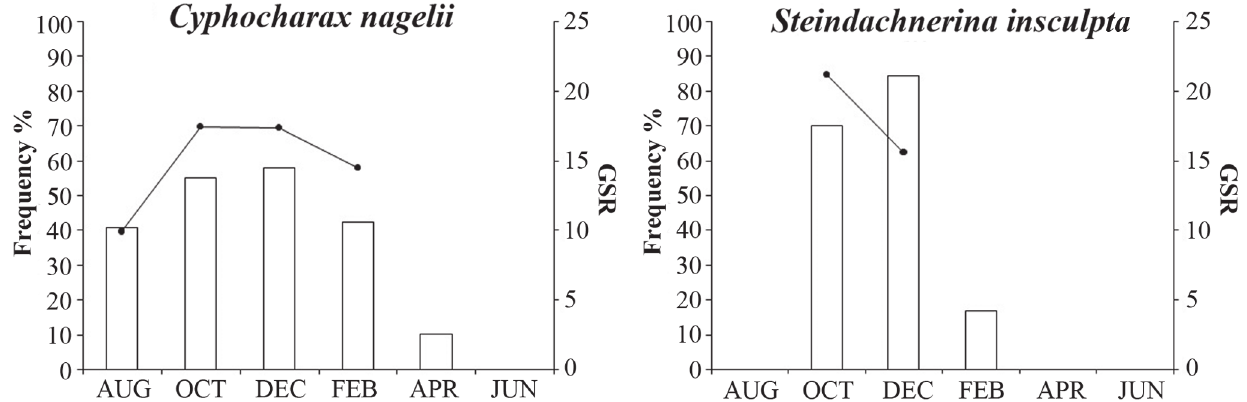
Fig. 3. Proportion of mature females (%) (columns) and values of gonadossomatic relationship (GSR) (lines) of both studied Curimatidae species between August 2005 and June 2006. Dry period: April-August; wet period: